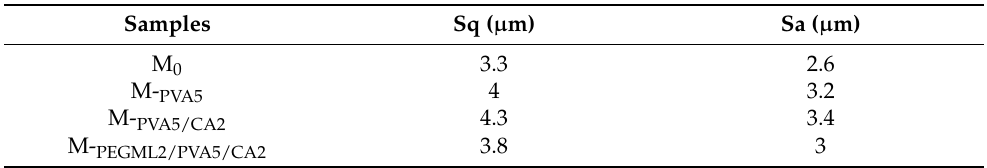
Figure 4. Surface morphology images of different PTFE microfiltration membranes (( a ): M 0 ; ( b ): M- PVA5 ; ( c ): M- PVA5/CA2 ; ( d ): M- PEGML2/PVA5/CA2 ). Table 2. Sq (Standard deviation of asperity height) and Sa (Mean height of asperity) values of different PTFE microfiltration membranes.